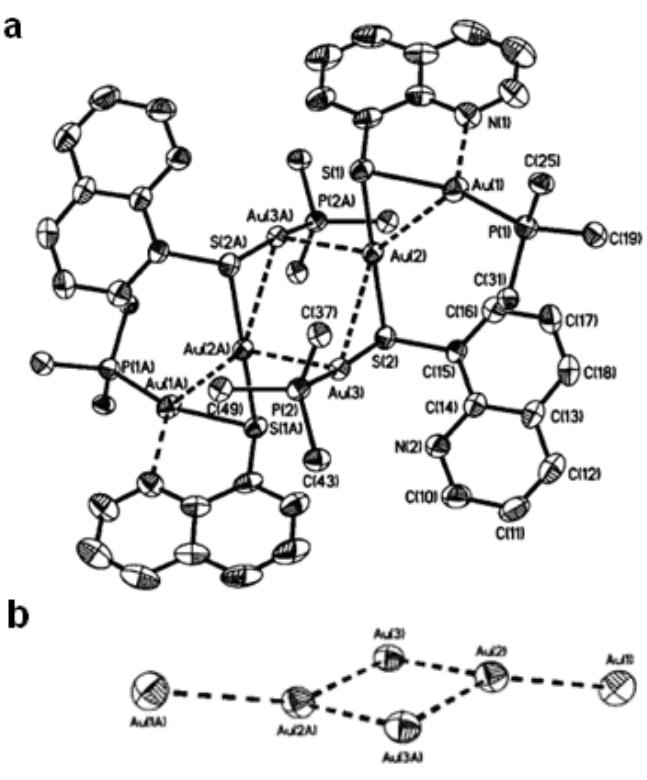
Figure 3. (a) Dimeric aggregate of complex {[(8-QNS) where the hexanuclear gold(I) supermolecule is connected by intermolecular Au(2) ··· Au(3A) contact of 3.1135(3) Å. The coplanar arrangement of the six metal ions is shown in (b). Reproduced with permission from